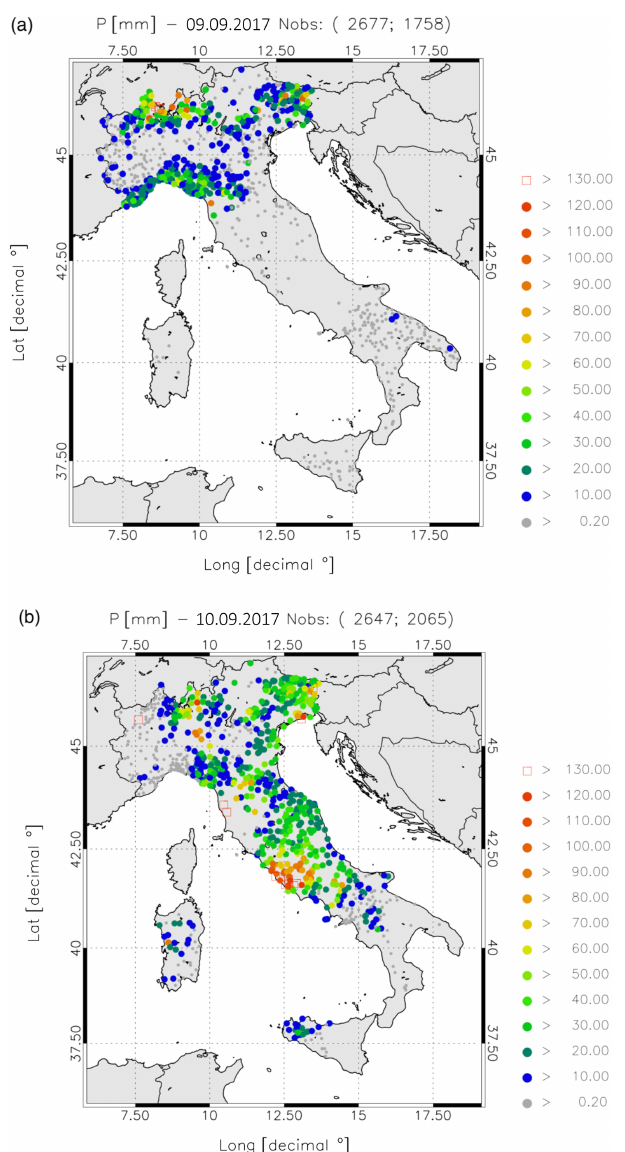
Figure 6. (a) As in Fig. 1 but for (a) 9 September 2017 and (b) 10 September 2017.